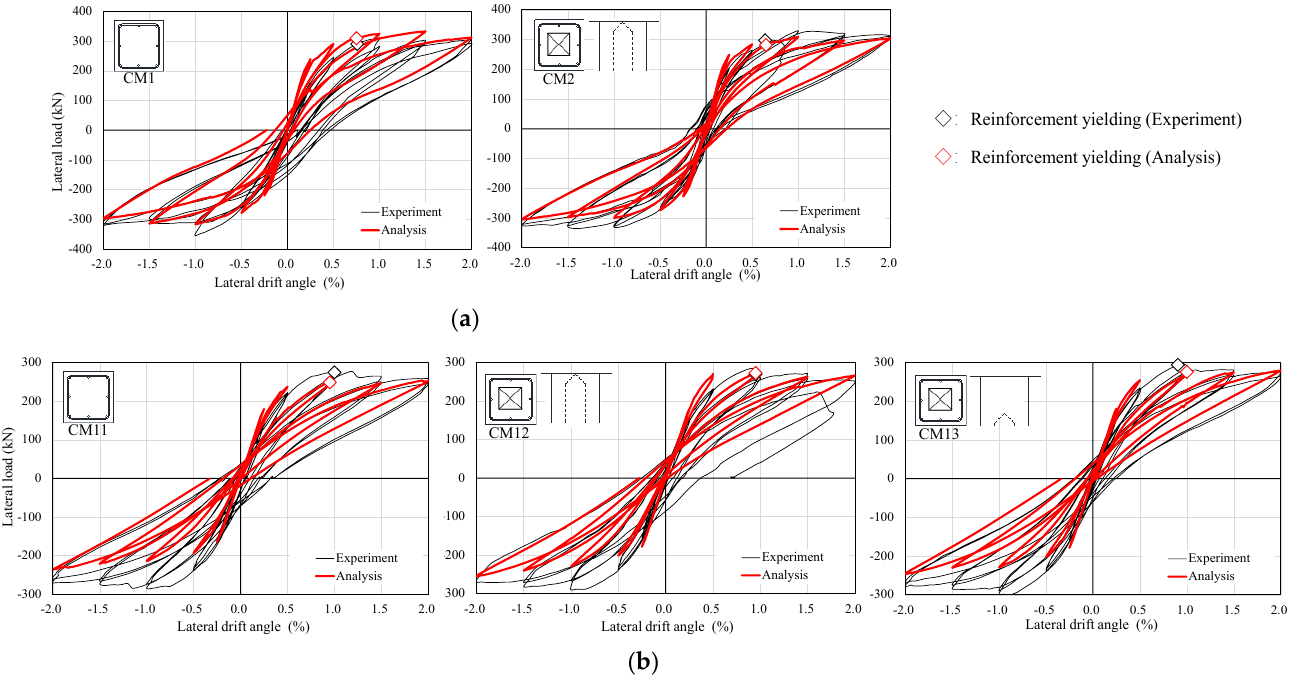
Figure 17. Comparison of hysteresis curves: ( a ) N-series; ( b ) S-series. Table 7. Maximum strength by calculation (FEM analysis) and experiment.